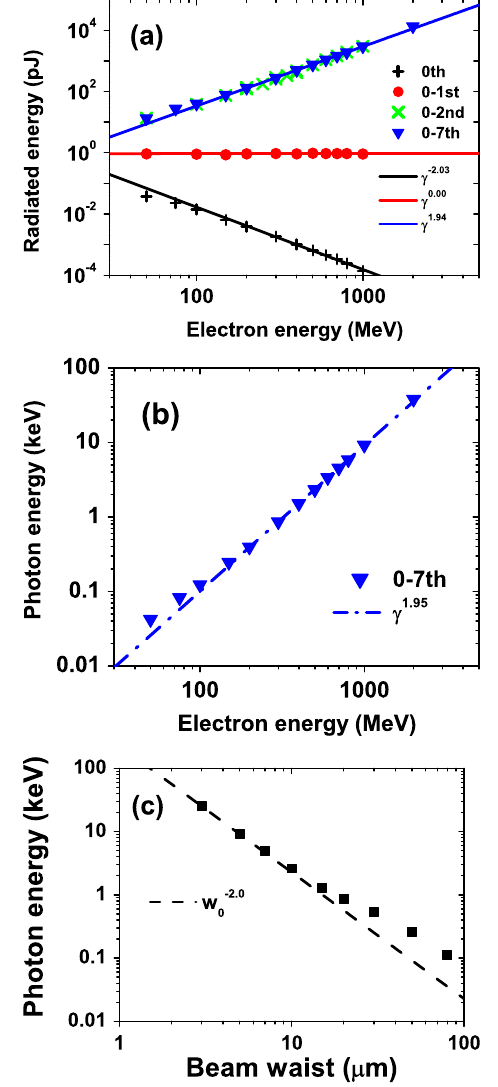
FIG. 6. Dependence of (a) the total radiated energy I with the effect of high-order fields in " and (b) the average photon energy K on (cid:8) . (c) Dependence of the average photon energy on w normalized vector potential of the laser a 0 is 10, beam waist of laser w 0 is 5 (cid:1) m , and the radius of the electron bunch is 30 (cid:1) m . The radiation energies are for a 0.5 nC electron bunch, which has been scaled up linearly from results calculated with a small number of electrons. Each point is the average of the four sets of simulations. Standard deviations were always < 5% ; error bars are omitted because they are not visible on the log